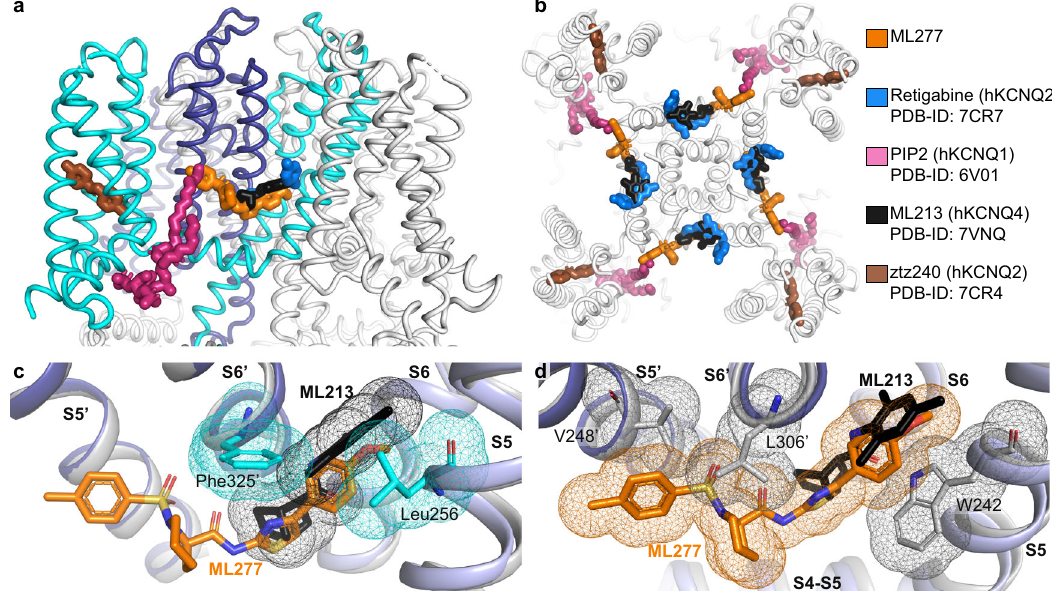
Fig. 6 Binding of ML277 and other KCNQ regulators to xKCNQ1 and hkCNQ4. a , b Overview of published KCNQ-ligand binding plotted on the xKCNQ1- CaM-ML277 structure. Different isoform structures were aligned based on the pore-forming domain. a View from within the plane of the membrane. Cyan and blue for the two subunits comprising the ML277 binding pocket. b Top view from the extracellular side clipped at the level of the ML277/ML213/ retigabine binding sites for clarity. c Superposition of hKCNQ4-CaM-ML213 (gray) onto xKCNQ1-CaM-ML277 (different shades of blue for different subunits, xKCNQ1 residue side chains shown in cyan) ML277 is shown in orange, and ML213 in black. Van der Waals surfaces indicate potential clashes. d Superposition of xKCNQ1-CaM-ML277 onto hKCNQ4-CaM-ML213 (ML213 in black and hKCNQ4 residue side chains in gray). Van der Waals surfaces indicate potential clashes between ML277 and hKCNQ4 residues W242, L306 ′ and V248 ′